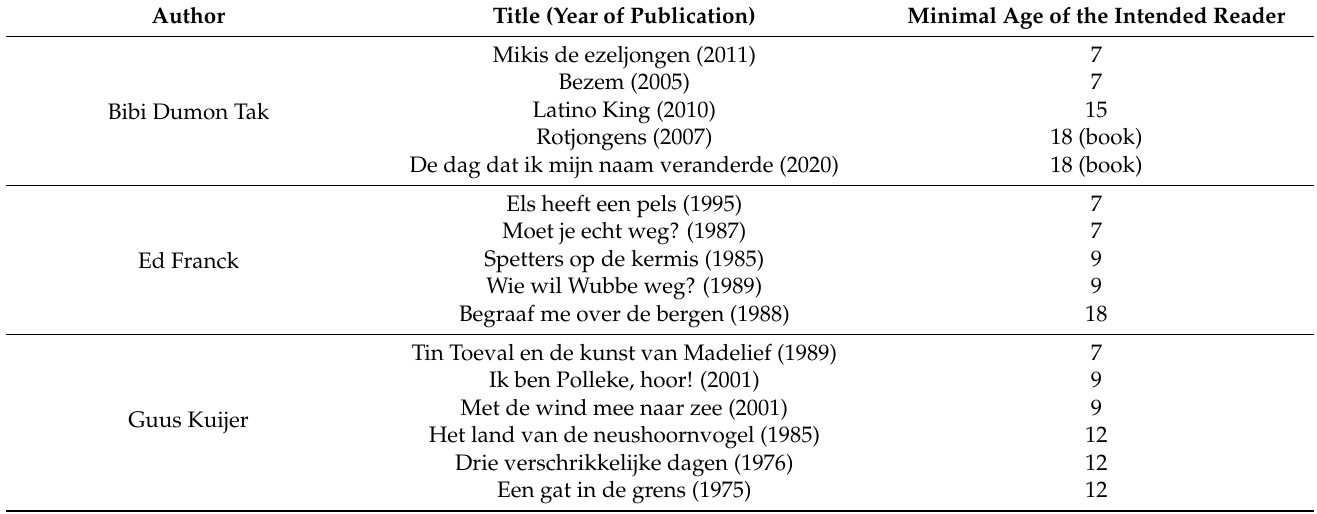
Table A1. List of novels included in the corpus of this article and the corresponding age of the intended